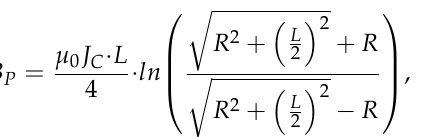
Figure 8. Applied magnetic field Ba ( t ) and magnetic induction at the center of the cylindrical HTS bulk Bo ( t ) .